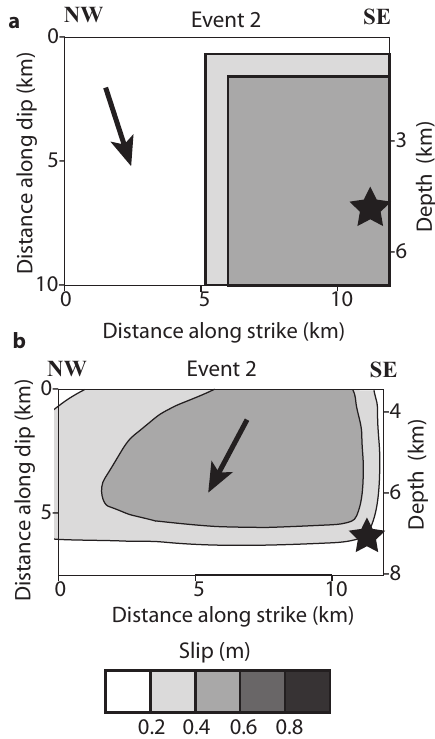
Fig. 4a,b. Simplified slip distribution of event 2 ob- tained by a) joint inversion of DInSAR and GPS data (Belardinelli et al ., 2003, model a in their table II) and b) inversion of strong-motion data (Capuano et al ., 2000). An elastic homogenous half-space is assumed for inversion of geodetic data and a layered half-space (table II) for strong motion inversion. In each panel the black star represents the location of the hypocenter on the fault plane and the arrow represents the inverted direction of slip, assumed as homogeneous on the whole fault plane. In panel a slip is obtained by linear interpolation of the inverted solution outside the patch with the largest slip (53 cm). Figure in panel b is re- drawn after Emolo and Zollo